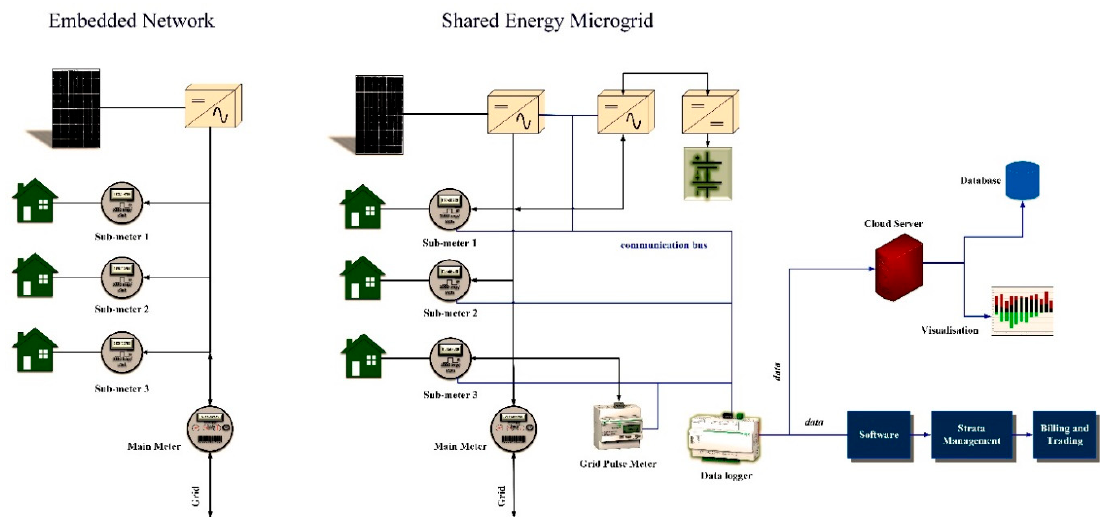
Figure 1. An embedded network ( left ) and shared energy microgrid ( right ).